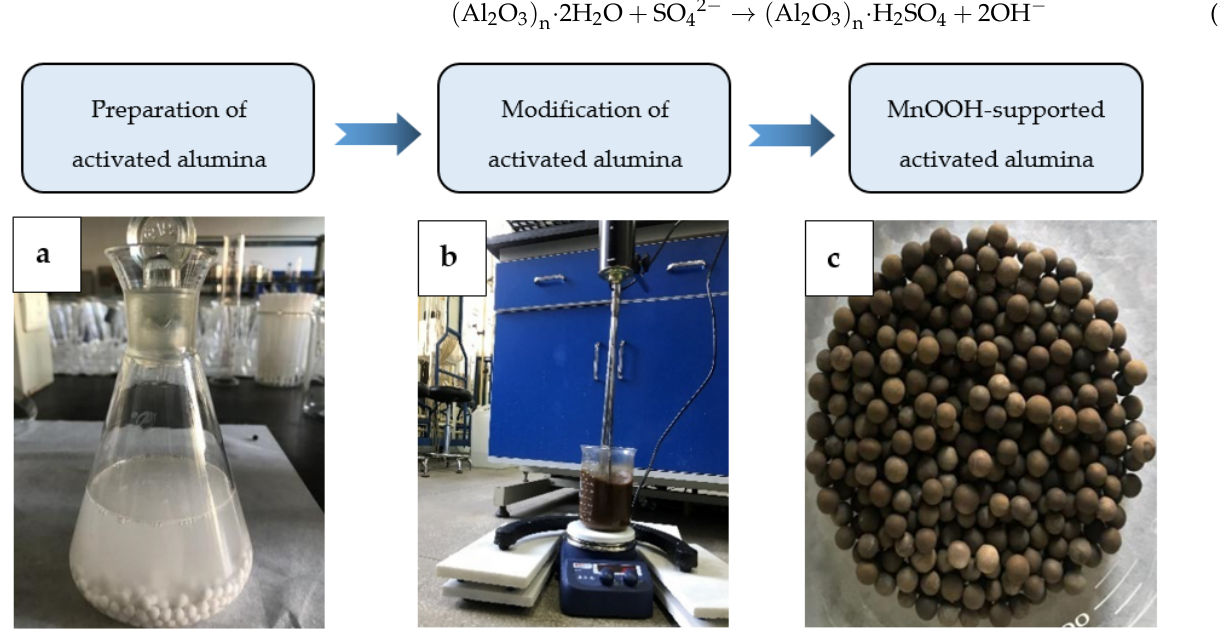
Figure 1. Schematic diagram for the preparation process of MnOOH-supported AA.